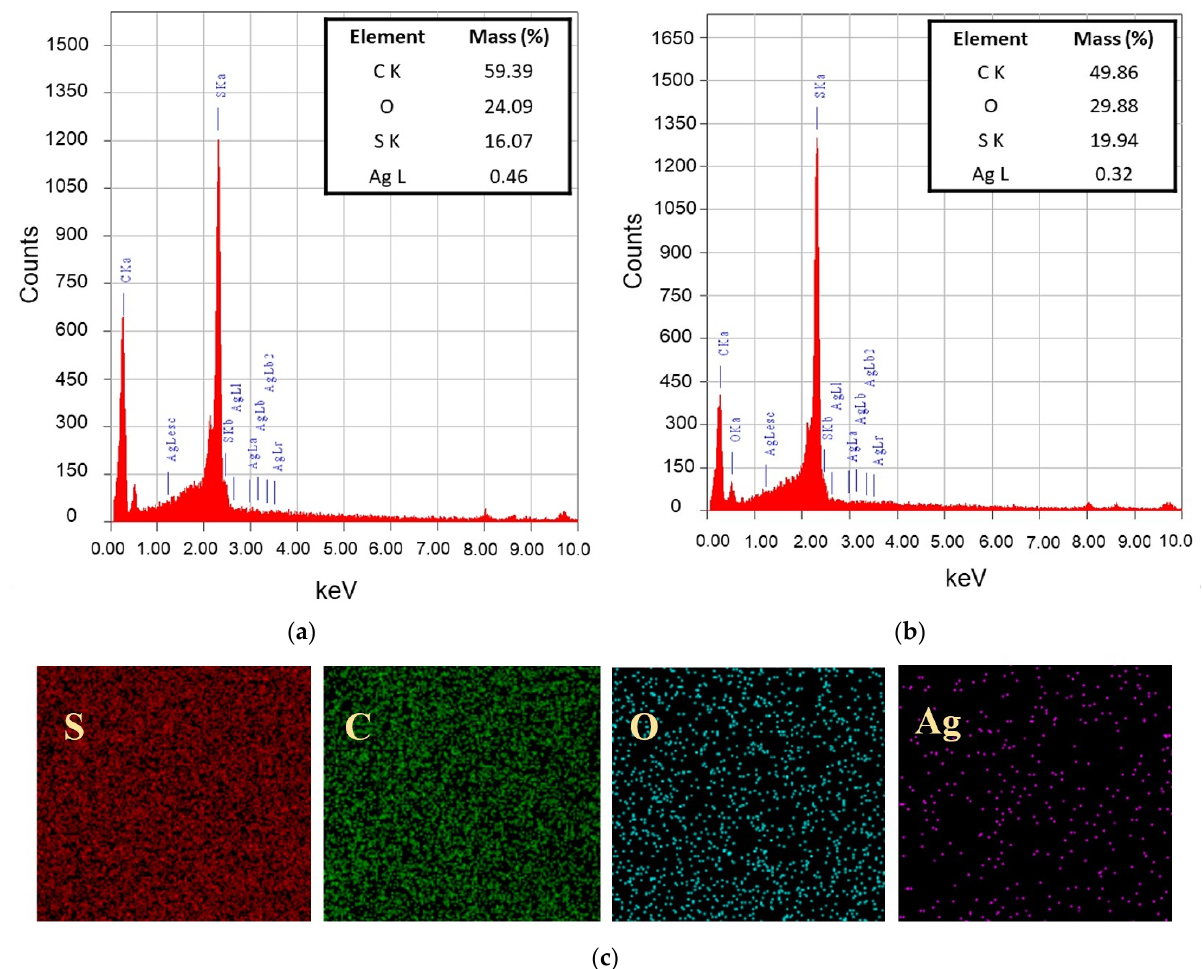
Figure 5. EDS elemental identification for Pag ( a ) and PPAg3 ( b ) membranes; topology of PPAg3 membrane surface ( c ).